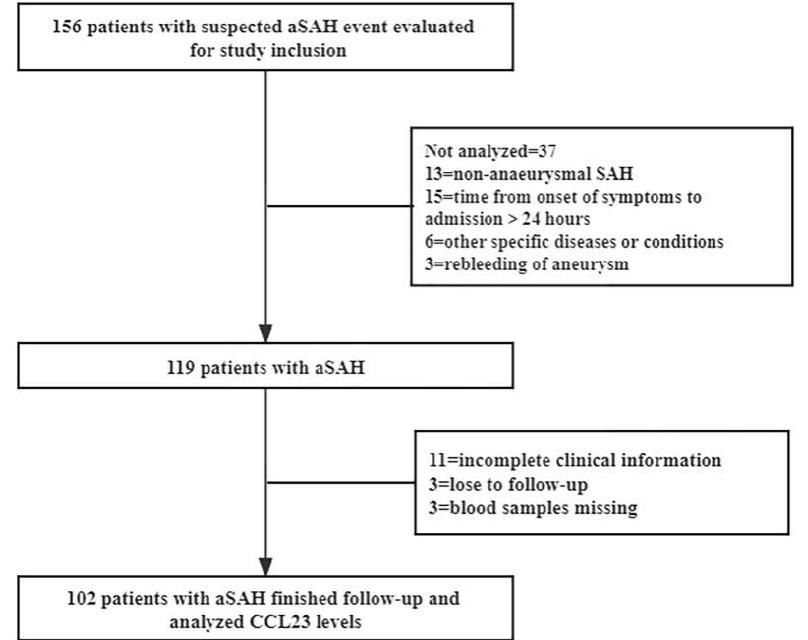
Figure 1. Flow chart of the study population.